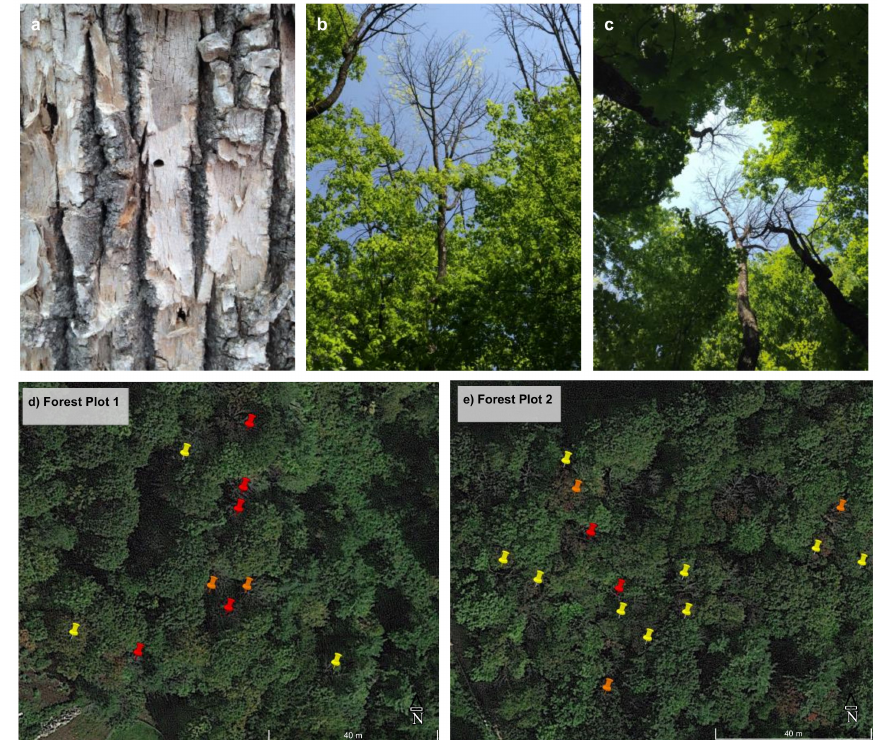
Figure 2. Evidence of emerald ash borer (EAB) impact and relative locations of study trees: ( a ) D-shaped exit hole in trunk from an emerging adult beetle; ( b ) thinning canopy of an impacted tree; ( c ) bare canopy and conspicuous light gap surrounding EAB-killed trees; ( d ) study trees from Plot 1; and ( e ) Plot 2 on a 11 September 2017 true-color satellite image, where red indicates trees that were dead from the start of the study, orange indicates trees that died during the study, and yellow indicates trees that were stressed by the end of the